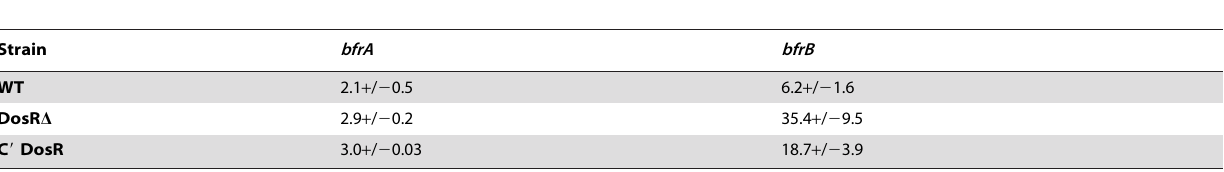
Table 1. Expression of bfrA and bfrB in M. tuberculosis